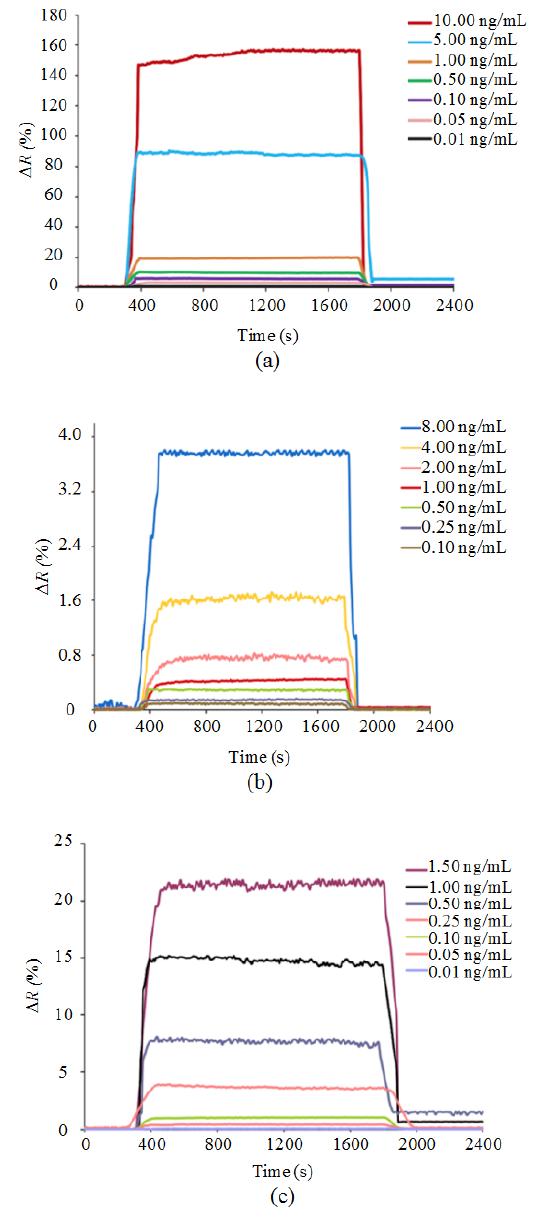
Fig. 6 Effects of the concentration [(a) vitamin B2 imprinted SPR sensor, (b) vitamin B9 imprinted SPR sensor, and (c) vitamin B12 imprinted SPR